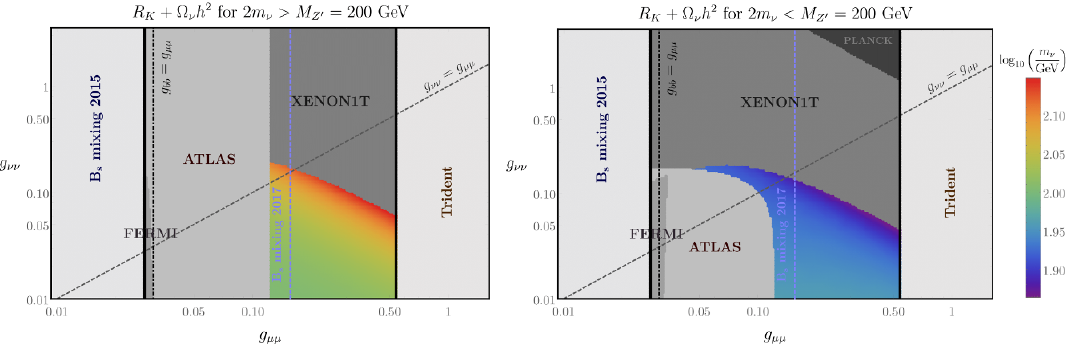
Figure 7 . Summary of the constraints for M Z 0 = 200 GeV. See text in section 5 for